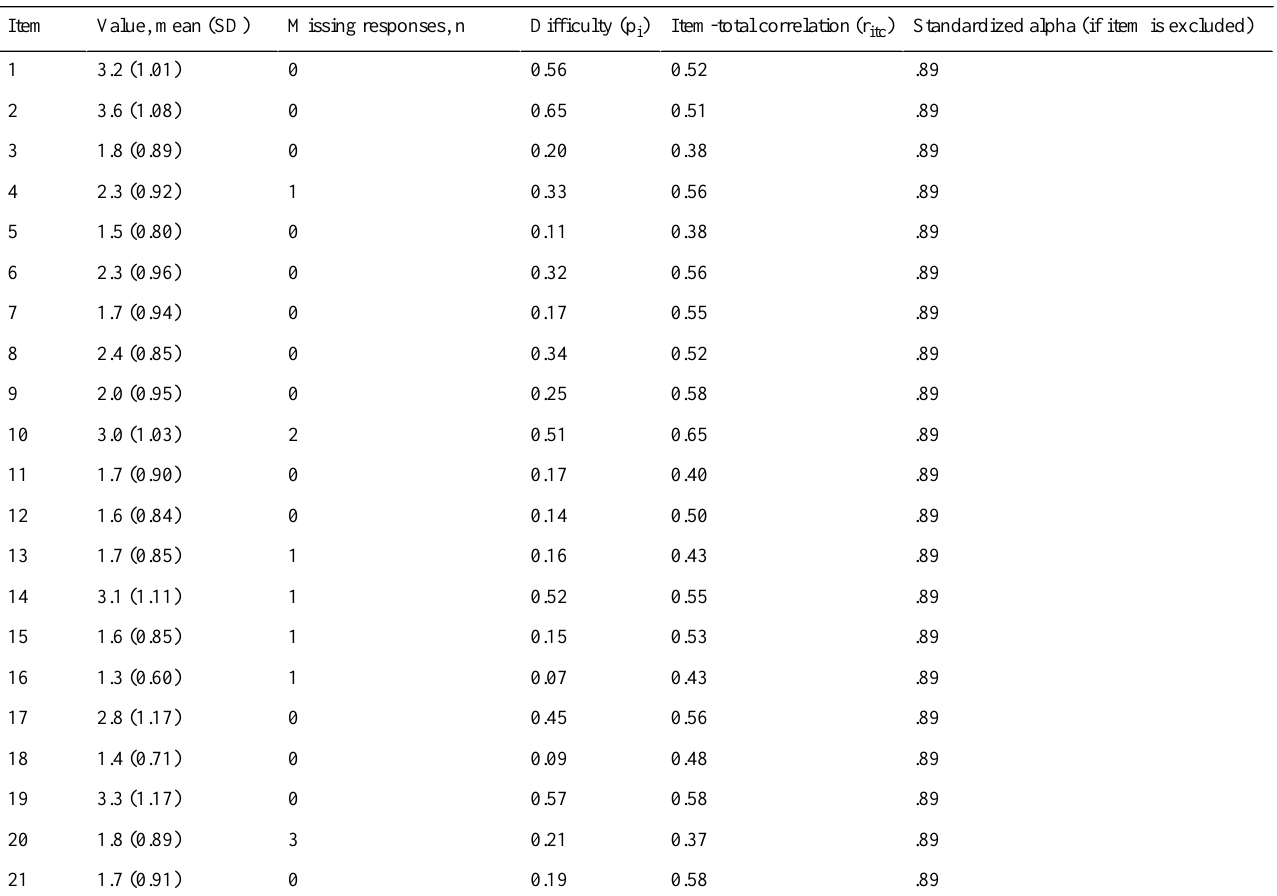
Table 1. Item means and standard deviations, missing responses per item, item difficulties, item-total correlations, and the internal consistency (standardized alpha) of the scale with single item exclusions